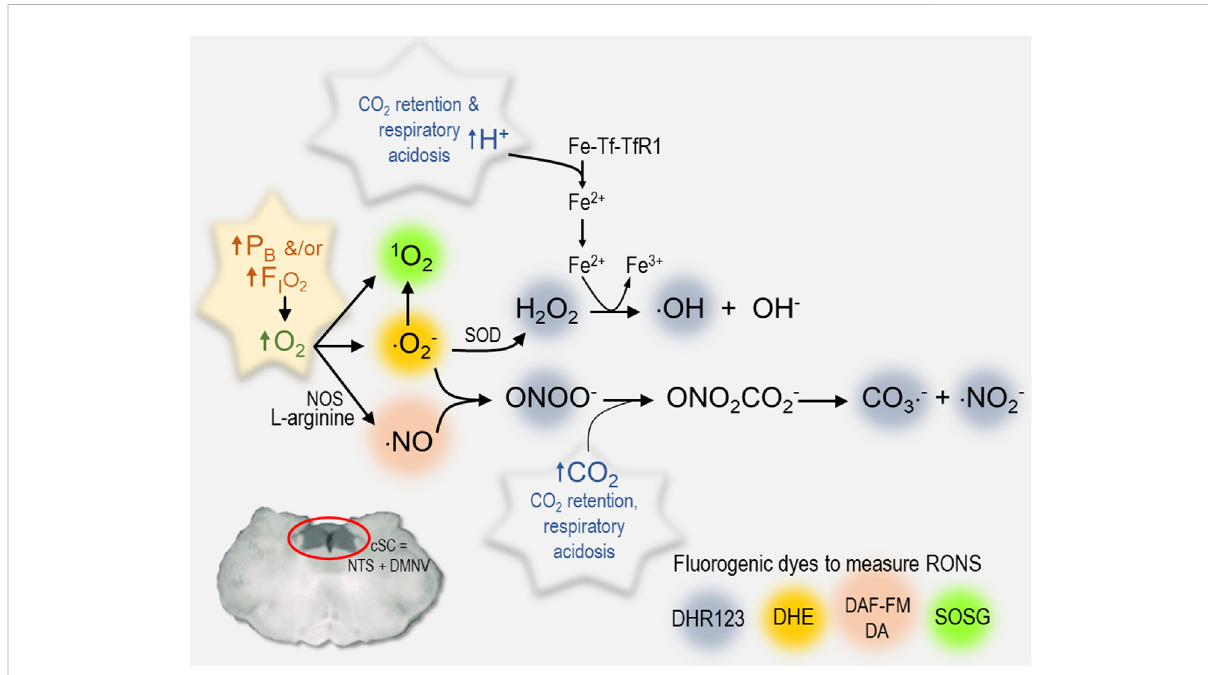
FIGURE 4 SummaryofvariousRONSmeasuredincSCcellsthatincreaseduringexposuretohyperoxia.Eachreactivespeciesiscolorcodedtoidentifythe fl uorogenic dye used to measure its production in rat brain slices ( 1 O μ M (Roberts et al., 2 , singlet oxygen) SOSG, Singlet Oxygen Sensor Green, 2.5 2017) ( · O 2 − , superoxide radical) DHE, dihydroethidium, 2.5 μ M (Ciarlone and Dean 2016b; Hinojo et al., 2021) ( · NO, nitric oxide) DAF-FM DA, 4- amino-5-methylamino-2 ′ ,7 ′ -di fl uoro fl uorescein diacetate, 5 μ M) (Matott et al., 2014; Ciarlone and Dean 2016b); an aggregate of RONS including hydrogen peroxide (H 2 O 2 ), hydroxyl radical ( · OH), peroxynitrite (ONOO − ), carbonate ( · CO 3 − ), and nitrogen dioxide radicals ( · NO 2 − ): DHR123, dihydrorhodamine 123, 10 μ M) (Ciarlone and Dean 2016c). Other abbreviations used include the following: cSC, caudal solitary complex; DMNV, dorsal motor nucleus of vagus; Fe-Tf-TfR1, transferrin + iron; Fe 2+ , ferrous iron; Fe 3+ , ferric iron; F I O 2 , fractional concentration of inspired oxygen; NOS, nitric oxide synthase; NTS, nucleus tractus solitarius; ONO 2 CO 2 − , nitrosoperoxocarboxylate; P B , barometric pressure; RONS, reactive oxygen and nitrogen species; SOD, superoxide